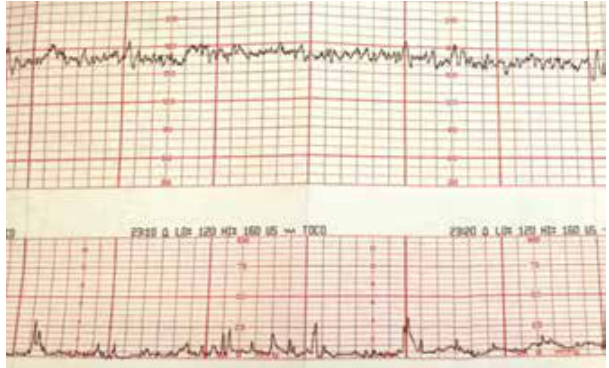
Figure 1: Cardiotocography of the patient scenario (question